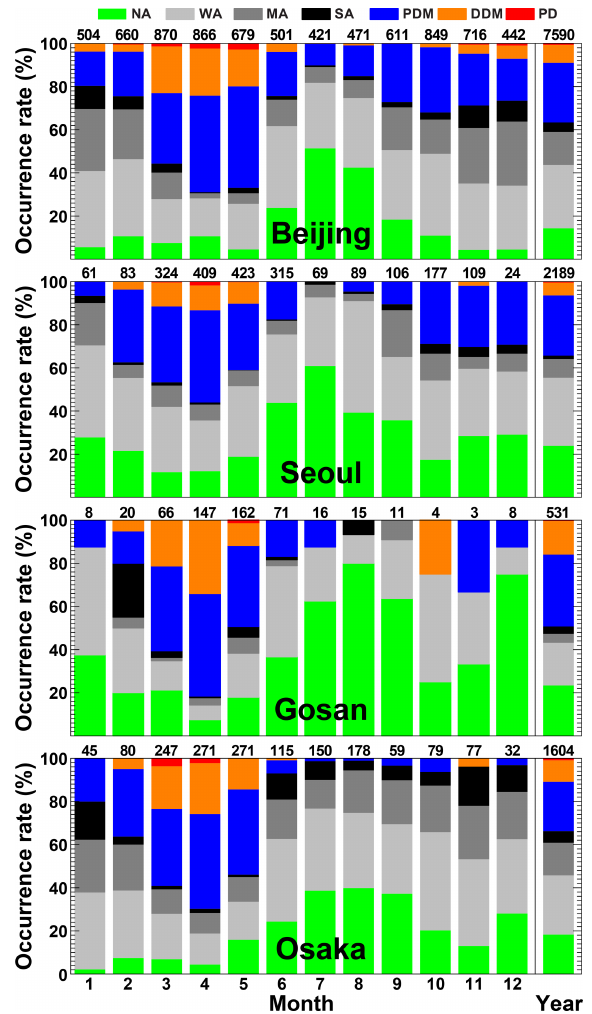
Figure 6. Monthly and annual occurrence rate of the aerosol types classified according to this study for AERONET sites in East Asia. The colour coding refers to the aerosol species introduced in Fig. 3. The numbers above the plots refer to the number of observations for which SSA and PLDR are available in the AERONET